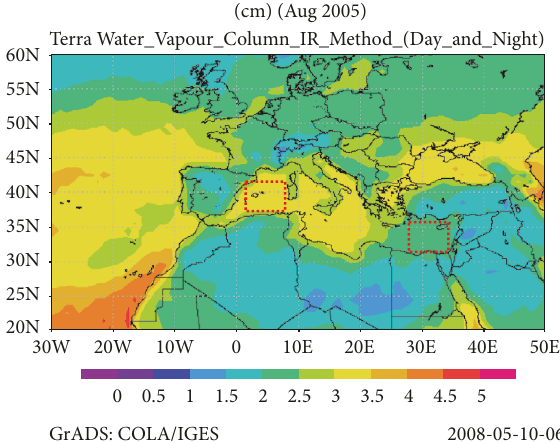
Figure 2: Mean values of the TPW column measured by TERRA during August 2005. Red squares indicate the two areas of study (wheremeantime-seriesofTPWvalueswerecalculated).Scaleunits are cm.